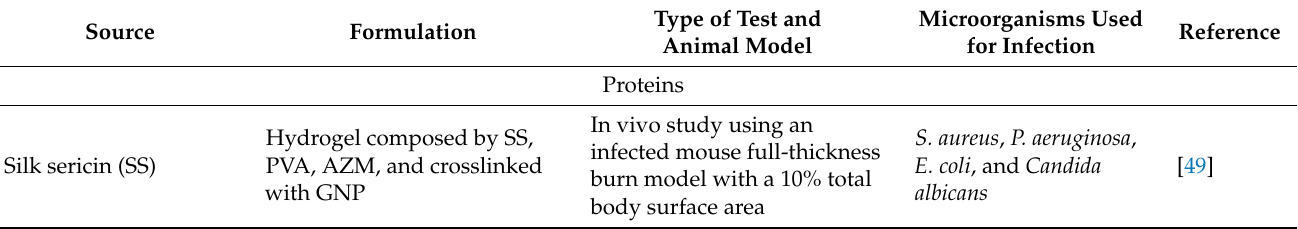
Table 1. Summarizes wound healing treatments based on proteins, lipids, and carbohydrates, in different scales (nano-, micro-, or macro-, the type of test (in vitro and/or in vivo), the animal model used in in vivo tests, and the cause of infection presented here as substantial advancements in injury therapies. Table 1. Recent treatments for wounds based on proteins, lipids, and carbohydrates, in macro-, or micro-, and nanoscale), the type of test (in vitro, in vivo, or both), the animal model (if any), and the cause of infection (if